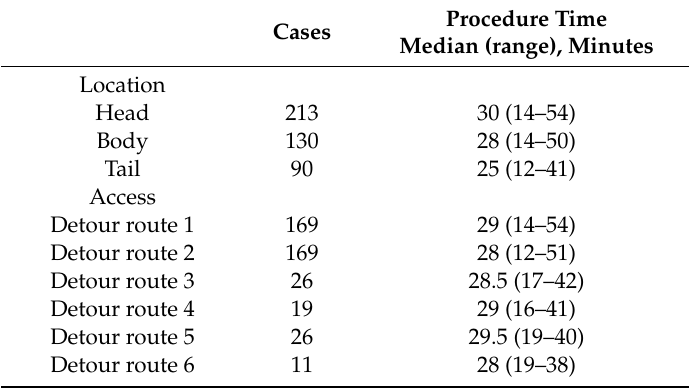
Figure A5. CT-guided core needle biopsy images via detour route 5. Table A1. Procedure time by tumor location and